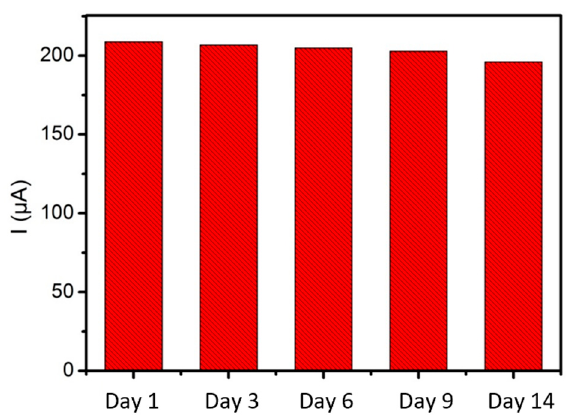
Figure 7. Histogram of the storage stability test.